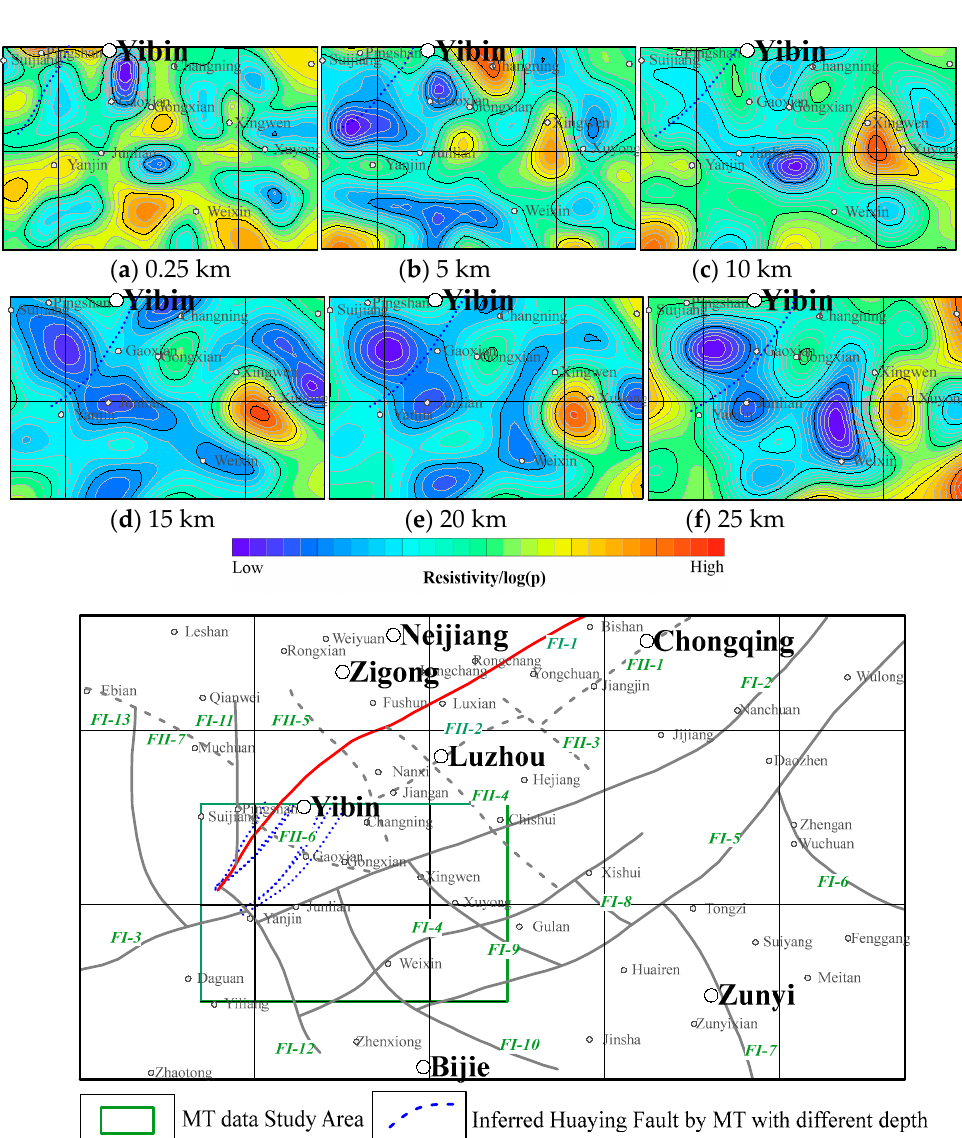
Figure 10. The inversion MT results from depth 0.25 km, 5 km, 10 km, 15 km, 20 km, 25 km.